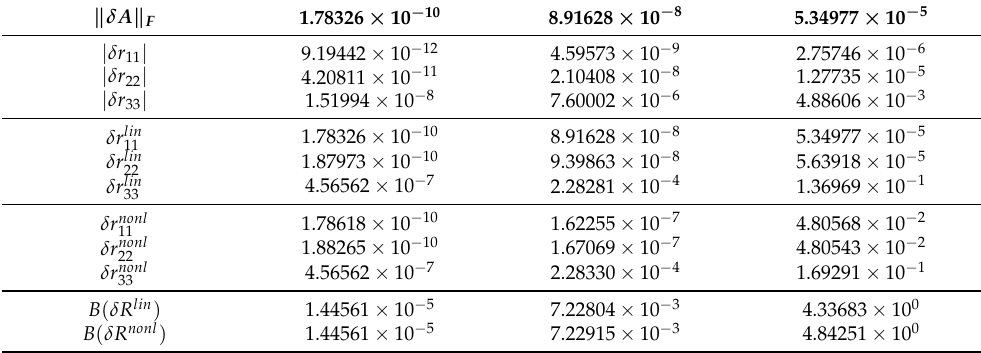
Table 5. Exact perturbations of the diagonal elements of R and their linear and nonlinear bounds. (cid:107) δ A (cid:107)